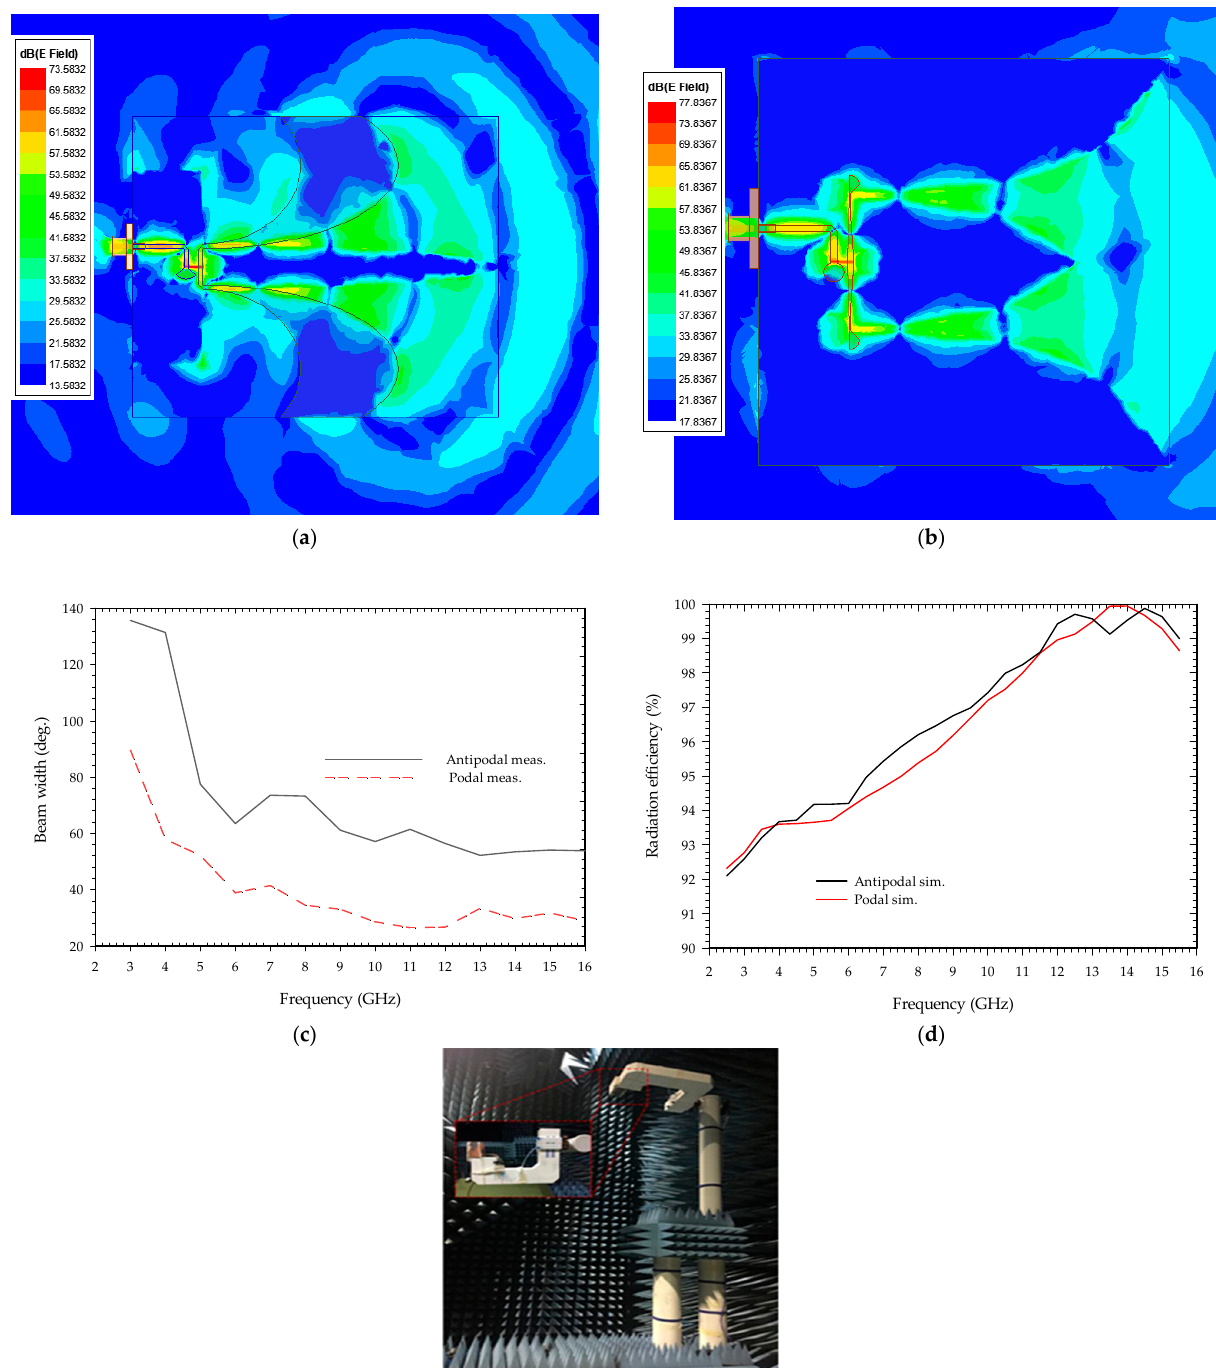
Figure 6. Simulated electric field distribution of the antenna and measured beamwidth: ( a ) 7 GHz antipodal antenna; ( b ) 7 Hz podal antenna; ( c ) Variation of beam width with frequency; ( d ) Simulated radiation efficiency of the antenna; ( e ) Measurement setup for the fabricated antennas.